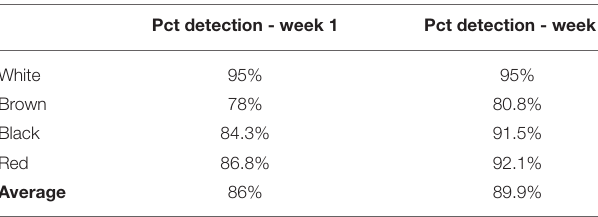
TABLE 2 | Percentage of detection of the animal detection